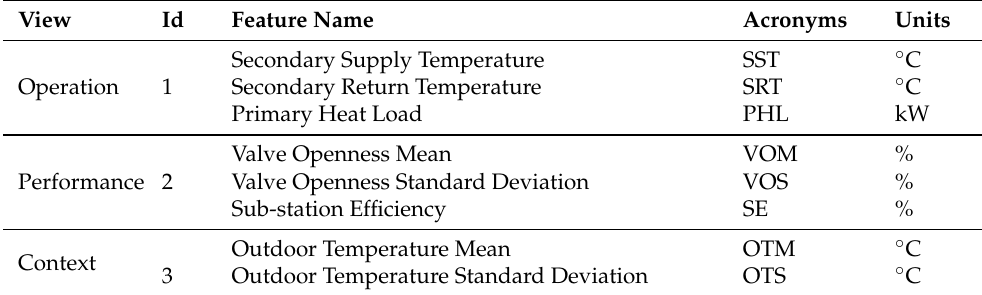
Table 1. Features used for monitoring the heating